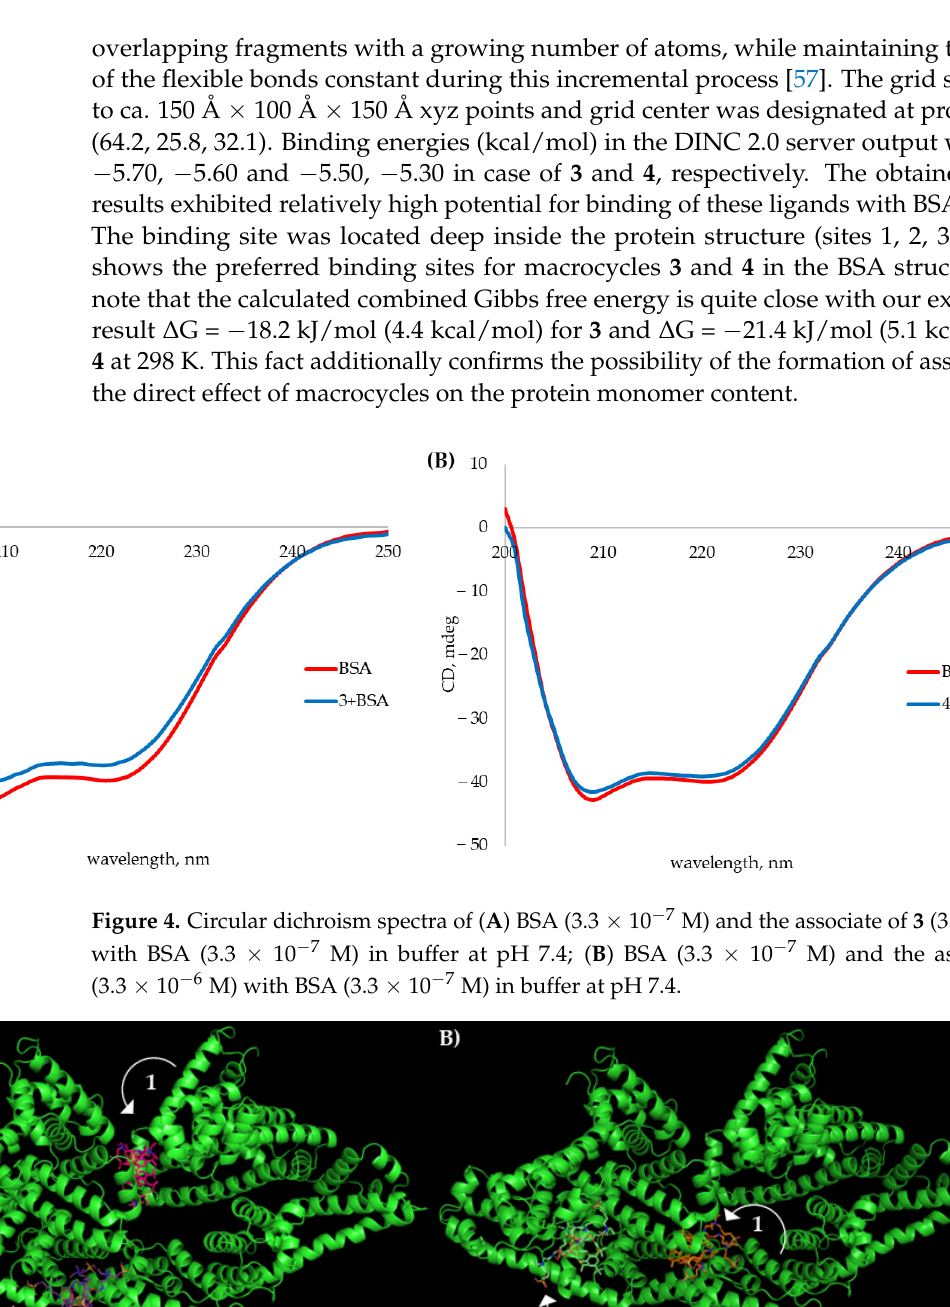
Figure 5. Potential sites for binding macrocycle 3 ( A ) and 4 ( B ) in BSA molecules calculated by DINC 2.0 web server.